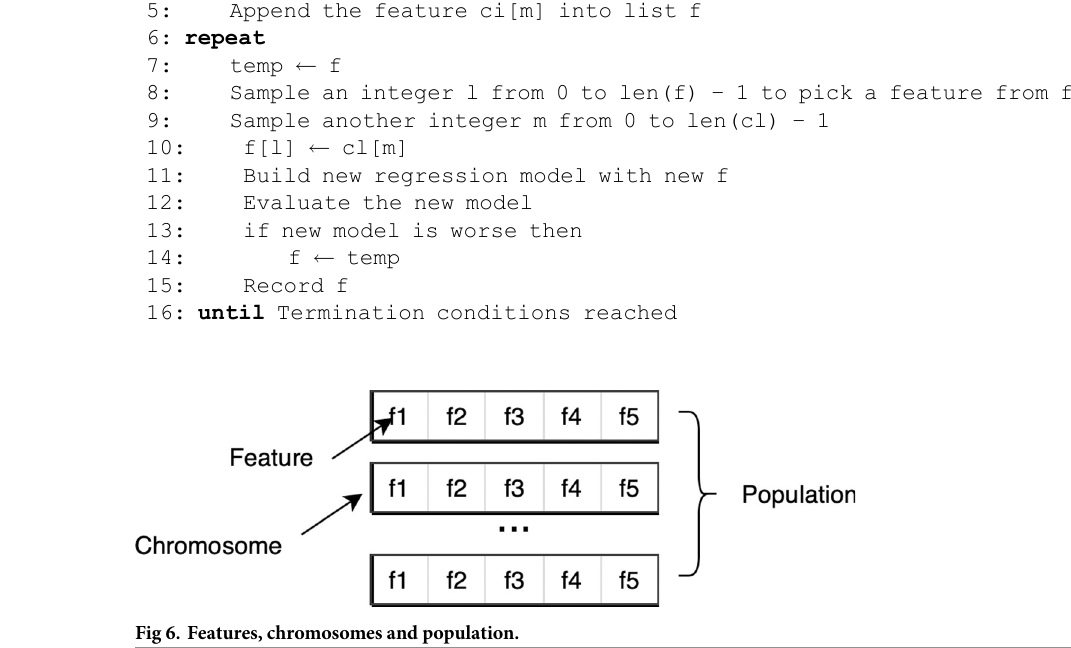
Algorithm 2 . K-means-clustering-based feature subset search algorithm.